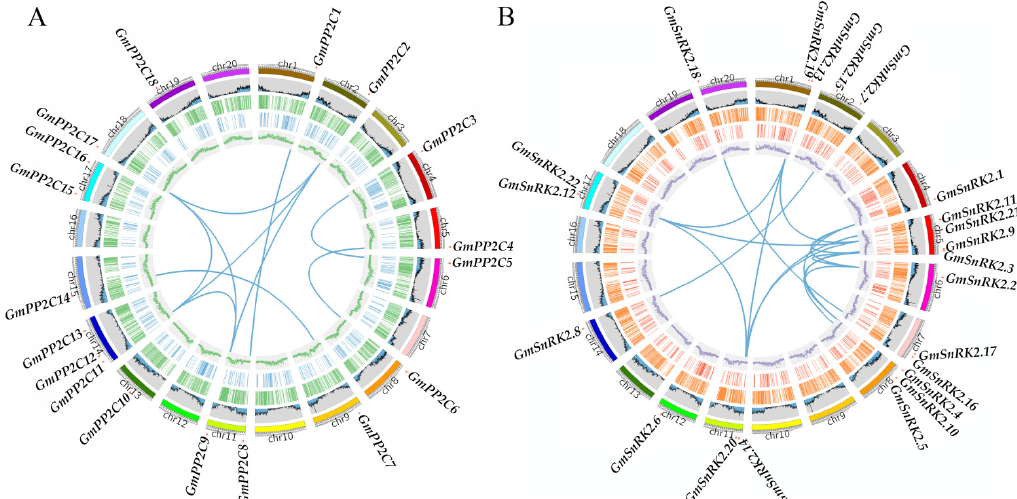
Figure 5. Chromosome distribution and synteny analysis of GmPP2C-A ( A ) and GmSnRK2 ( B ) genes. Chromosomes 1–20 are illustrated in different colours. The approximate locations of all the genes are shown with short red lines. The blue curves indicate segmentally duplicated genes. The tracks from outside to inside represent the gene density, methylated region distributions of Dos-DMR (process of soybean domestication, Dos-DMR), methylated region distributions of Imp-DMR (in the improvement process, Imp-DMR), and GC density.